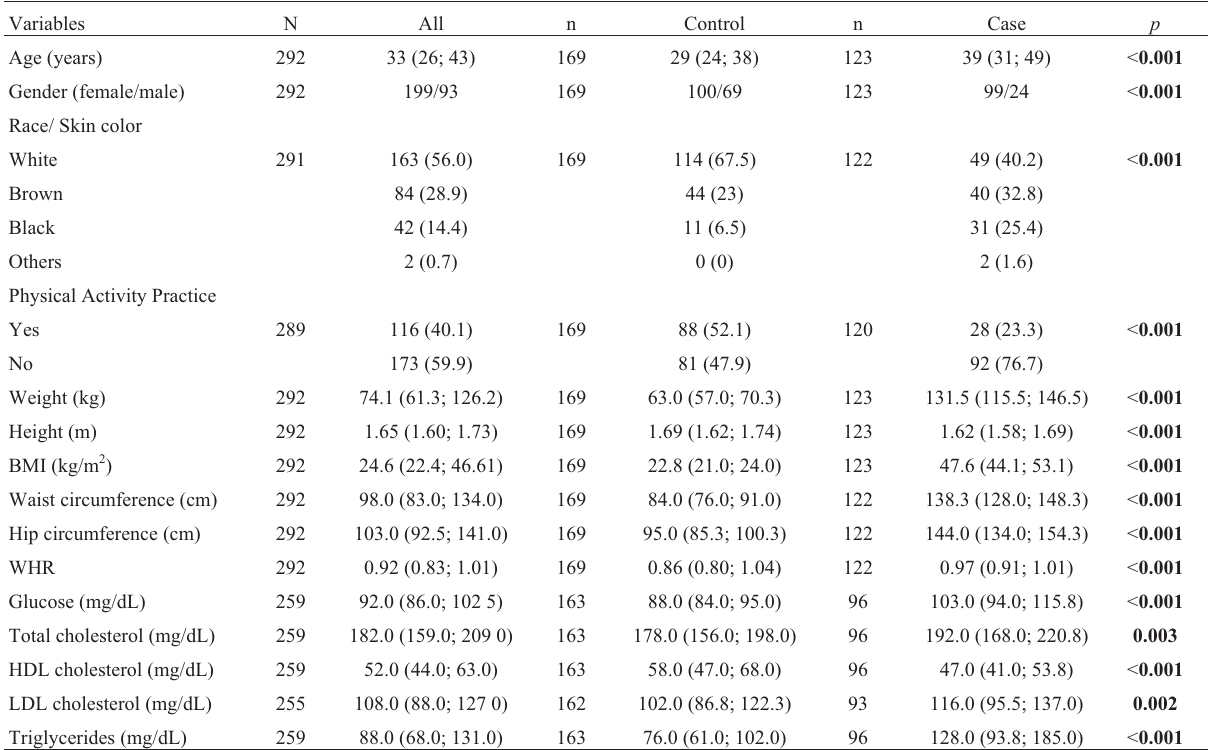
Table 1 - Characteristics of study